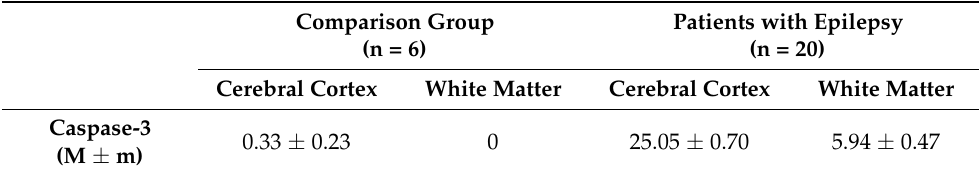
Table 1. Mean relative values (M) of caspase-3-positive glial cells in the temporal lobe brain tissue in the comparison group (without epilepsy) and in patients with epilepsy, mean error (m), number of cases (n), differences in the content of caspase-3 in the cerebral cortex compared to the comparison group statistically significant at p <